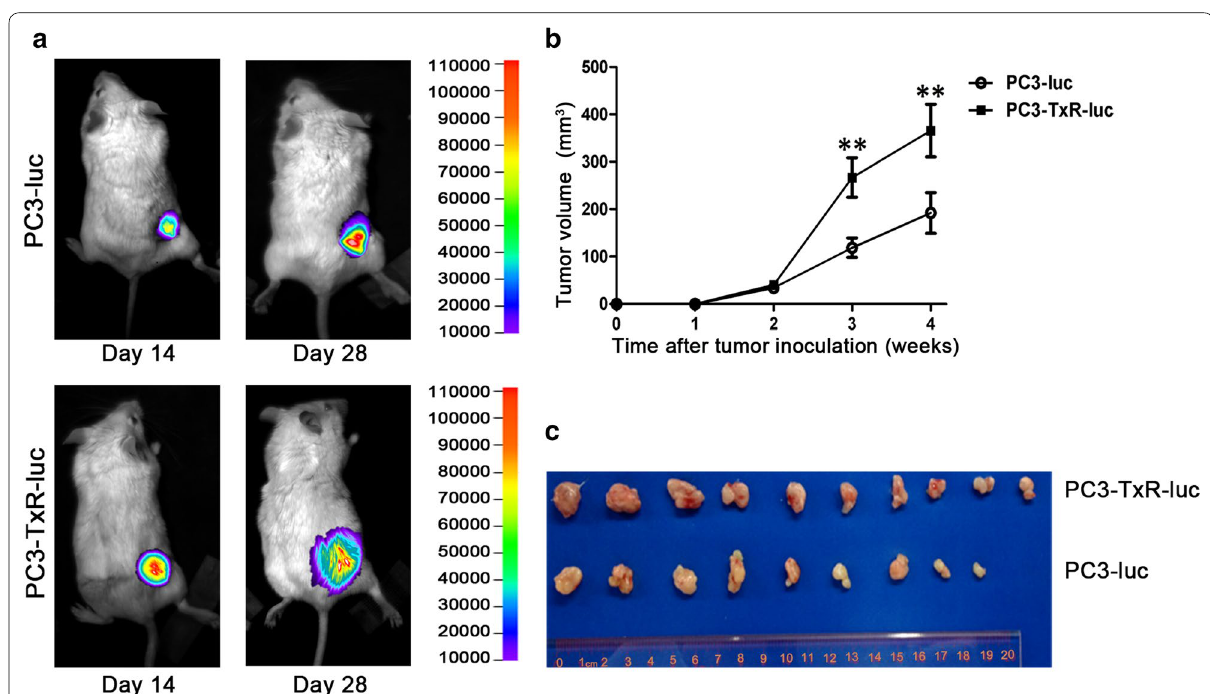
Fig. 3 Chemoresistant PCa cells demonstrate enhanced subcutaneous tumor growth in mice. a Luminescence imaging of tumors in mice. PC3 and PC3-TxR cells were transfected with luciferase lentivial vector to construct PC3-luc and PC3-TxR-luc cells, respectively. PC3-luc and PC3-TxR-luc cells (4 10 6 cells/mouse) were injected subcutaneously into the right back of male severe combined immune deficiency (SCID) mice, respectively; × live images on days 14 and 28 are shown. b Tumor growth curves of PC3-luc and PC3-TxR-luc cell xenografts. Tumor volumes were recorded once a week. The mean SEM values of data from 10 mice per group are presented. c The photo of subcutaneous tumors excised from mice when the ± tumor volume was approximately 1 cm 3 . * P < 0.05, ** P < 0.01